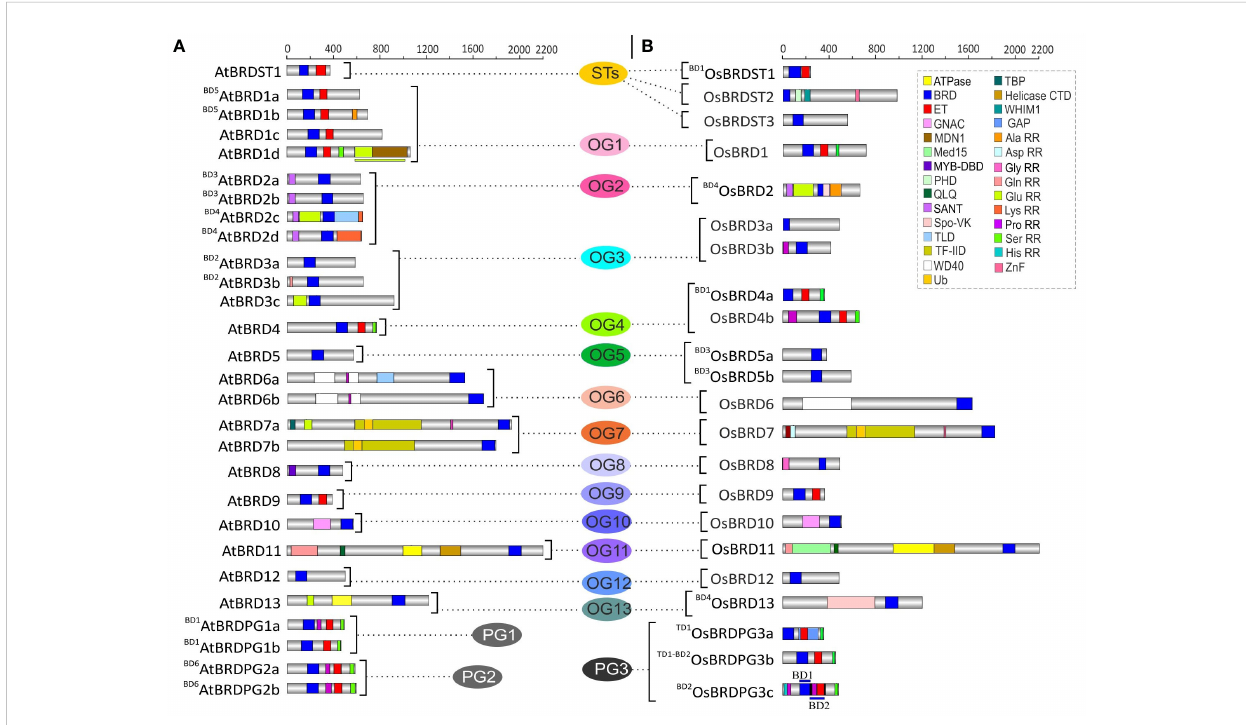
FIGURE 3 Comparison of domain architecture of BRD-proteins of A. thaliana (A) and O. sativa (B) belonging to thirteen ortholog groups (OG1-13), three paralog groups (PG1-3), and singleton category (STs). The BRD-members speci fi c to each group are arranged side-by-side for comparison, and the designations ‘ BD ’ and ‘ TD ’ in the names indicate the block or tandem duplication. Domains/important functional sites (CDD and PROSITE prediction) are shown by different color codes. In AtBRD1d, OsBRDPG3c, color-coded lines (above/below) indicate spread of domains to adjacent regions. Scale on the top indicates the protein length (number of amino